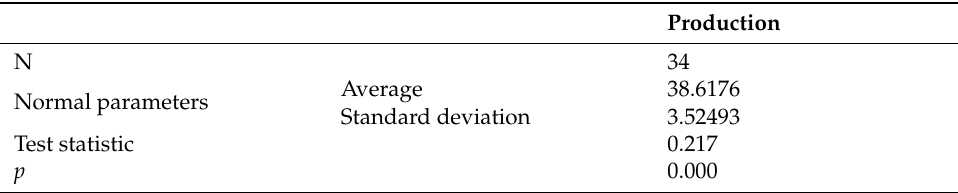
Table 3. Kolmogorov–Smirnov test.